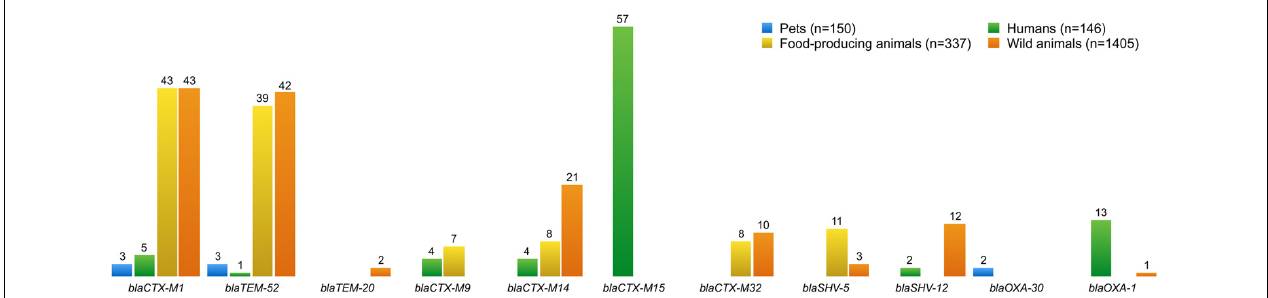
FIGURE 4 | Number of ESBL-producing E. coli and resistance genes present in all isolates from different groups. blaCTX-M15 was the most frequent ESBL gene recovered from E. coli , followed by blaCTX-M-1 and blaTEM-52. Otherwise, blaTEM-20, blaOXA-30, and blaCTX-M-9 genes were found in a few ESBL-producing E. coli .